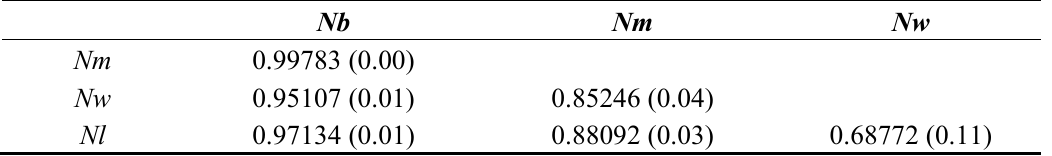
Table 3. The population differentiation parameter (F parentheses) between different populations of Neodiaptomus schmackeri . The values were calculated based on the COI gene according to the method of Hudson et al.